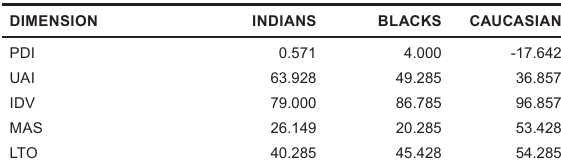
Table 3 Cultural Values: Separate Group VSM